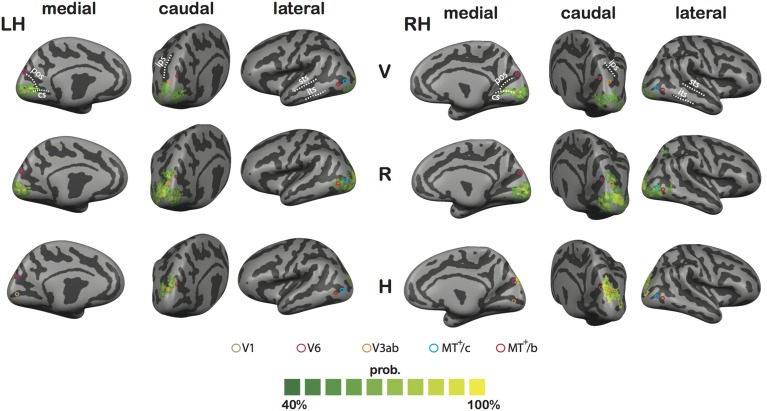
Results of the CBA analysis. Shown is the proportional spatial overlap (green to yellow) between subject's functional maps for V (top tow), R (middle row), and H (bottom row; p < 0.05, uncorrected for all individual contrasts). The proportion is projected on the averaged representation of left (LH) and right hemisphere (RH), which was derived from the average of all curvature information after CBA across subjects. Circles define approximate ROI locations, based on the Talairach coordinates reported in Table 1.